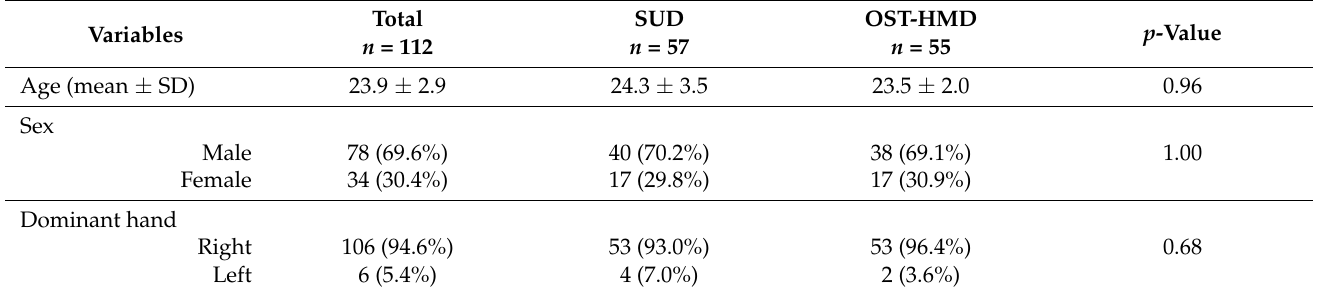
Table 1. Characteristics of participants and comparison between the SUD and OST-HMD